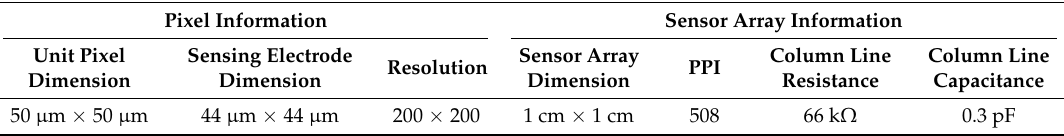
Table 2. The designed sensor array information.